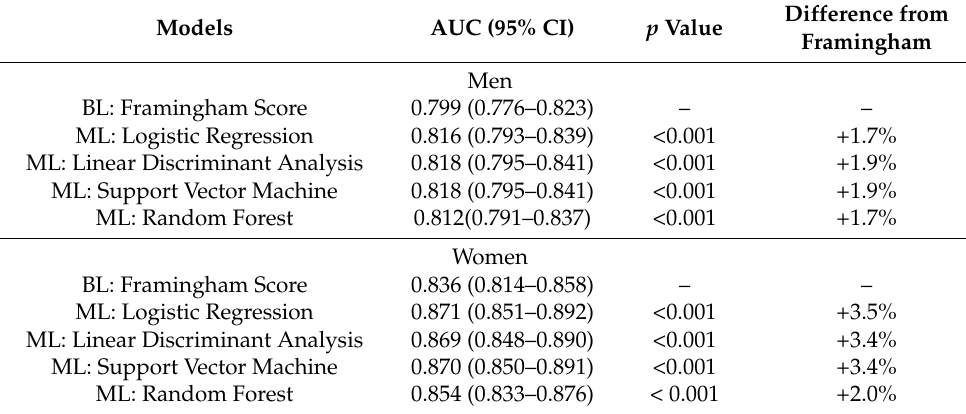
Table 6. Two-fold cross validation: Comparison of the performance of Framingham Score (baseline model (BL)) and four machine learning (ML) models predicting 15-year risk of CVD mortality using combined data based on Sex